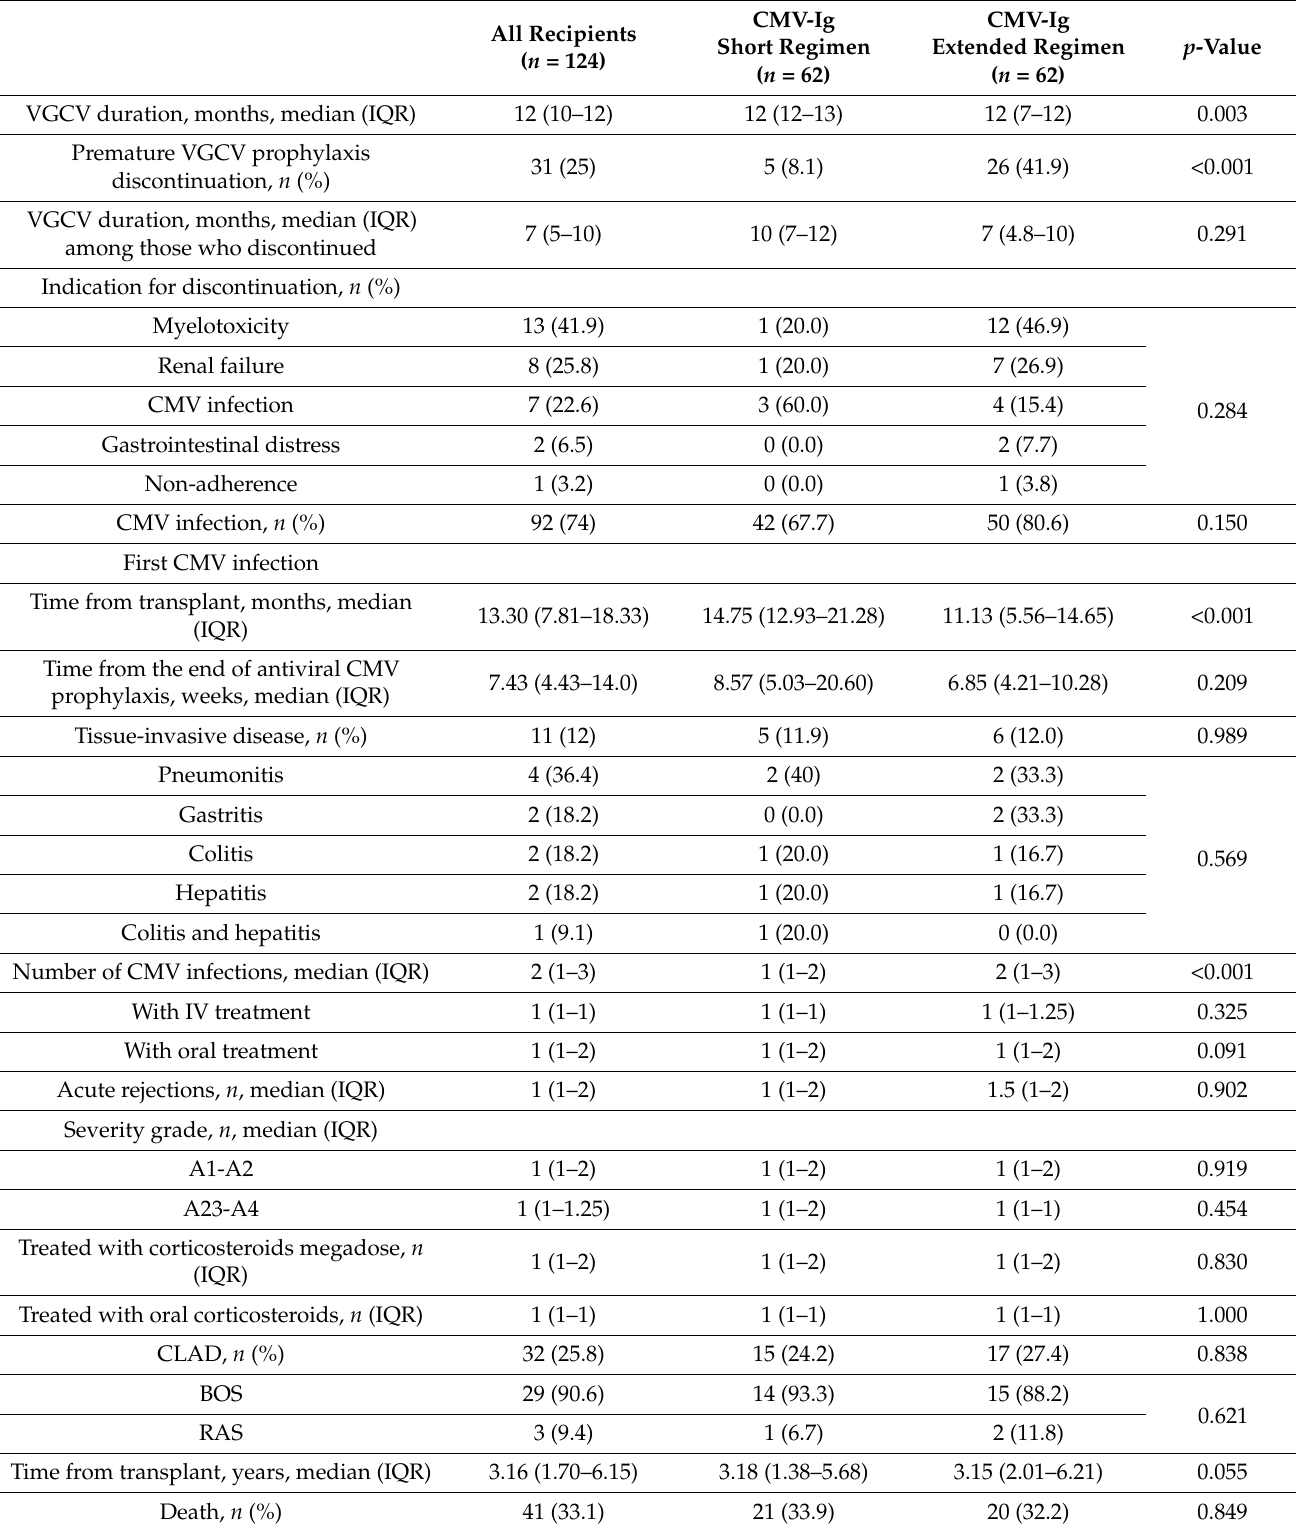
Table 2. Post-transplant outcomes of the lung recipients included in the study by adjunctive CMV-Ig regimen